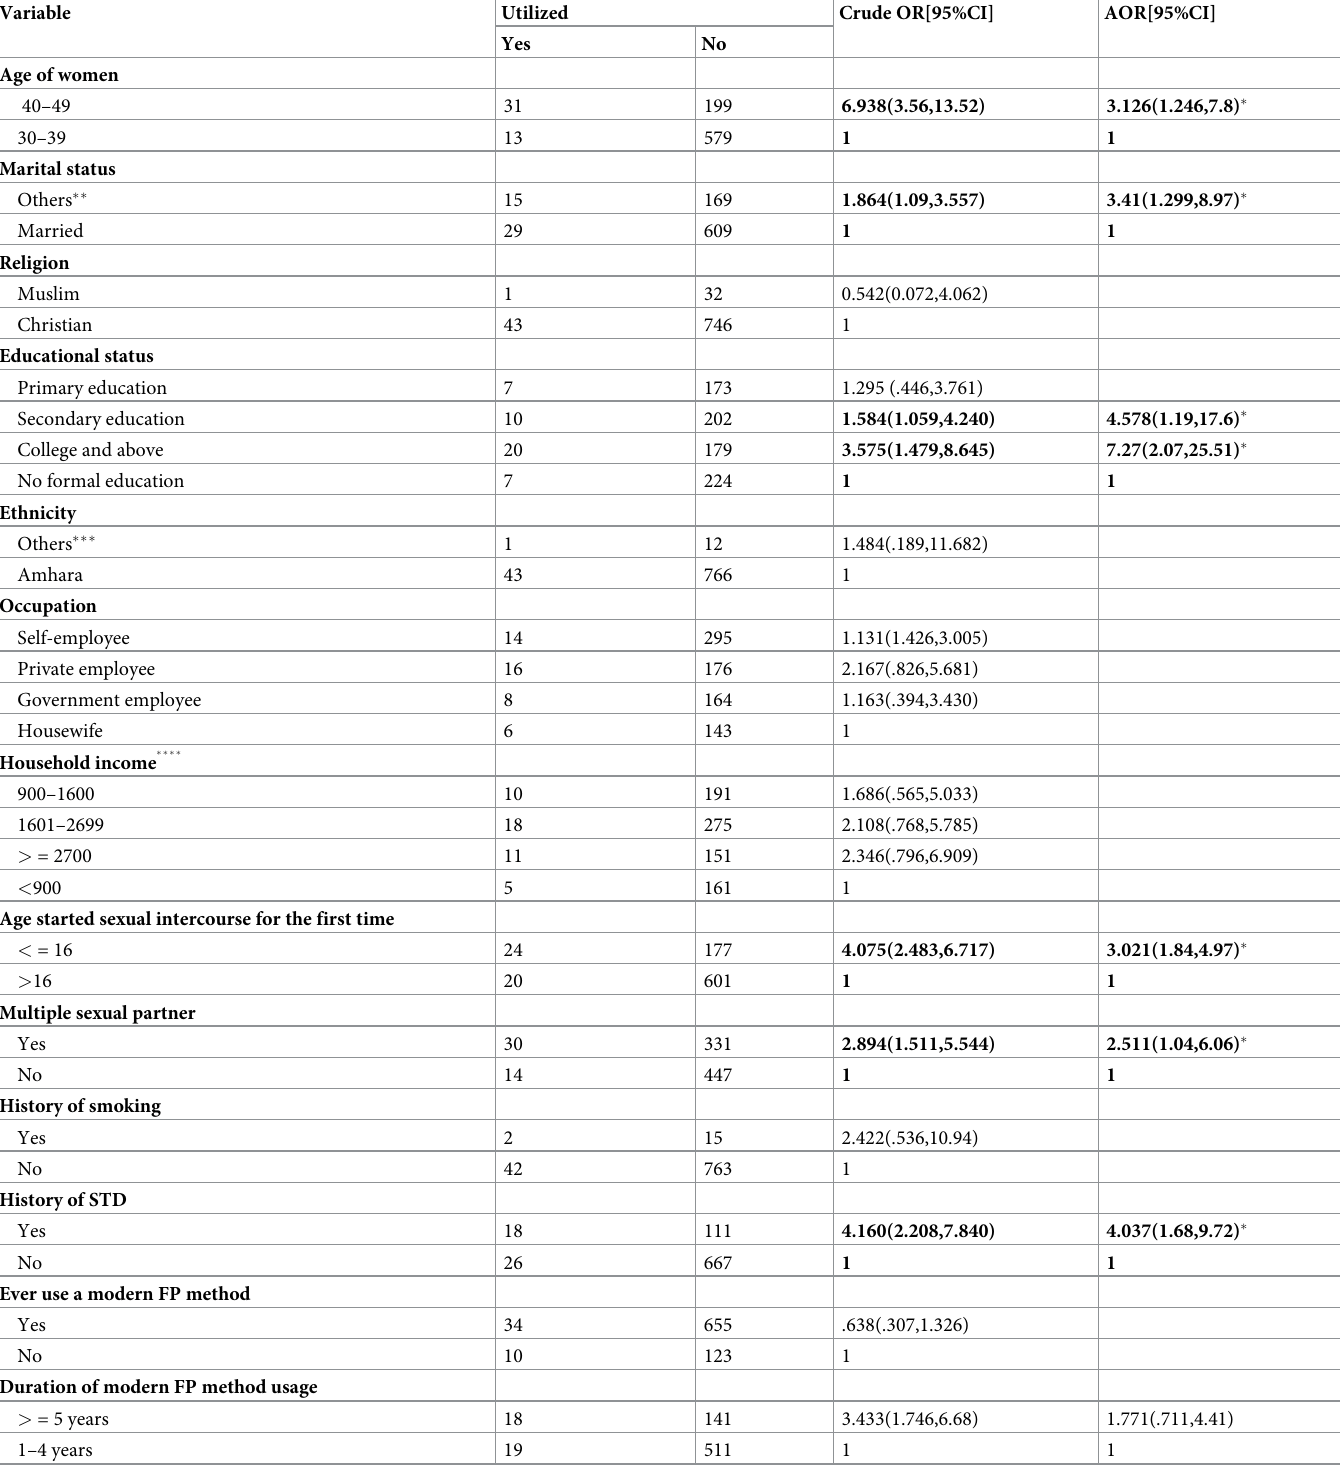
Table 6. Bivariable and multivariable analysis of factors associated with utilization of cervical cancer screening among women in Debremarkos town, Northwest Ethiopia, 2018.